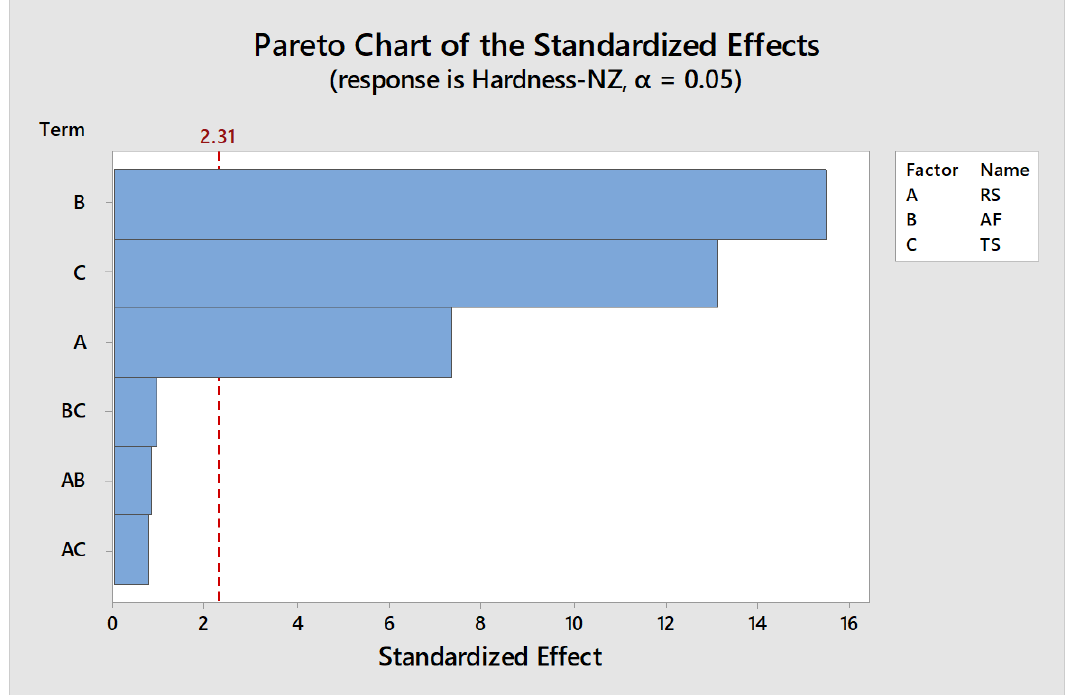
Figure 19. Pareto chart — hardness in NZ.